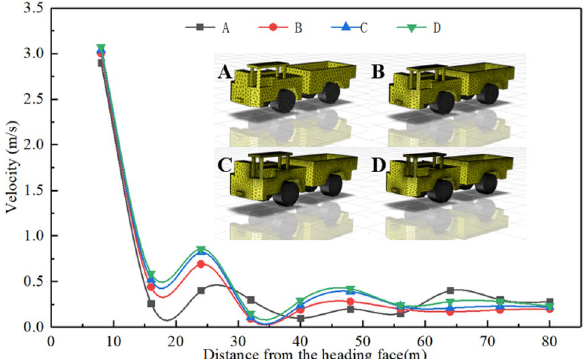
Figure 2. Grid independence